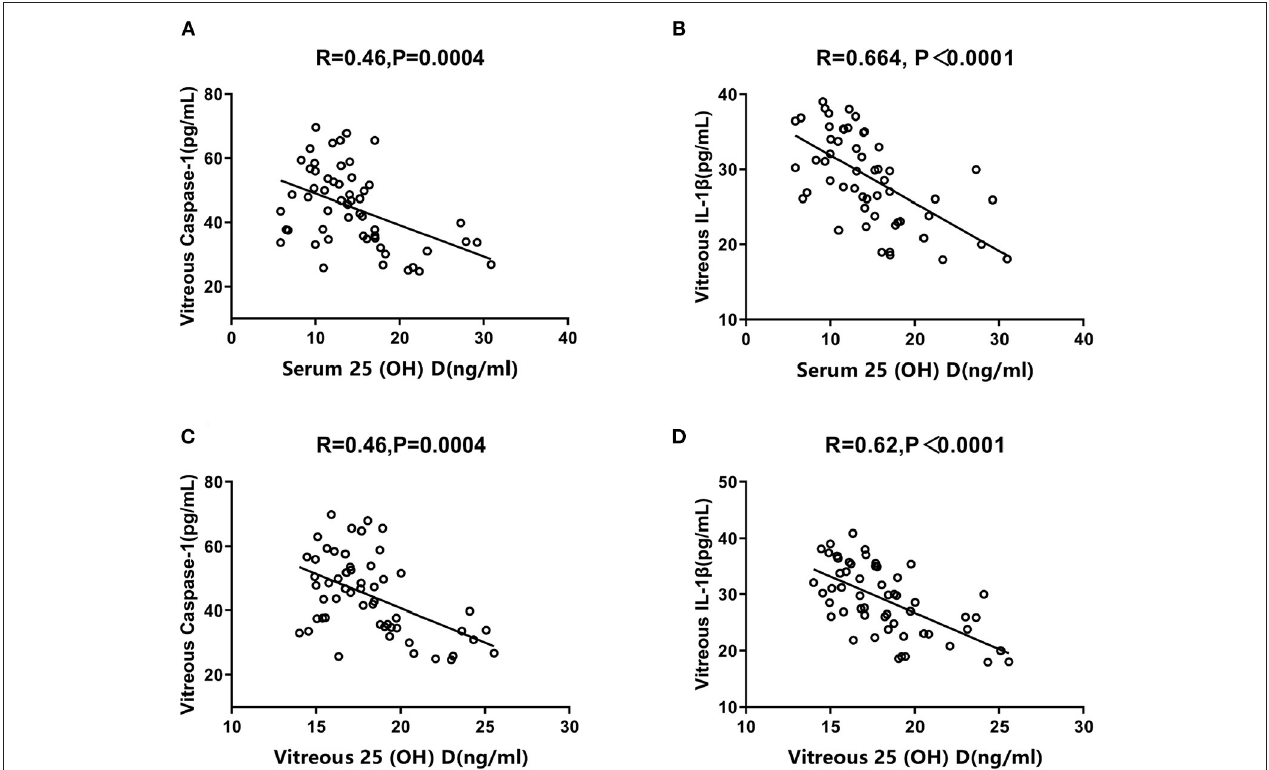
FIGURE 5 | Correlations between vitreous Caspase-1/IL-1 β levels and serum/vitreous 25 (OH) D concentrations in PDR group. Spearman’s correlation tests presented negatively significant correlations (A) between vitreous Caspase-1 level and serum 25 (OH) D concentration ( R = 0.46, P = 0.0004), (B) between vitreous